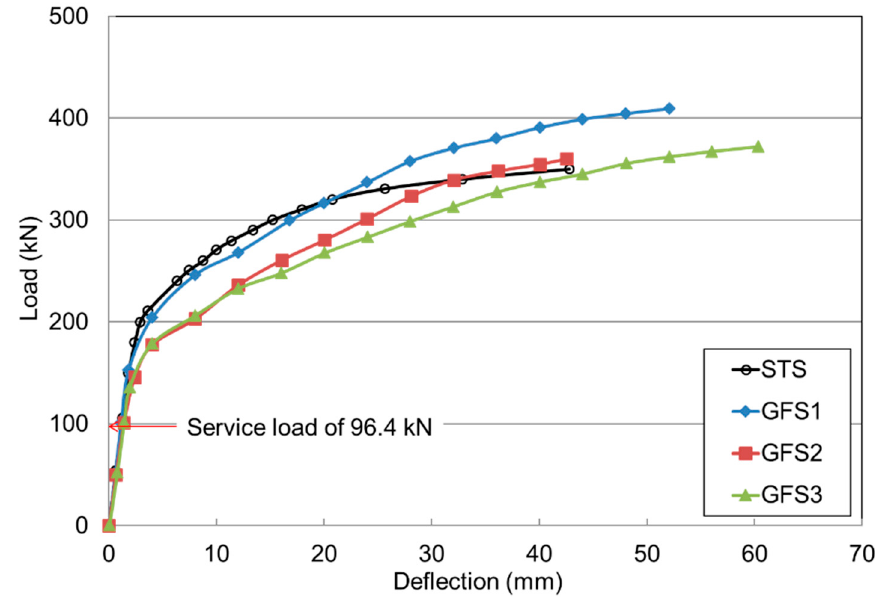
Figure 6. Load and deflection relationship of GFS specimens.